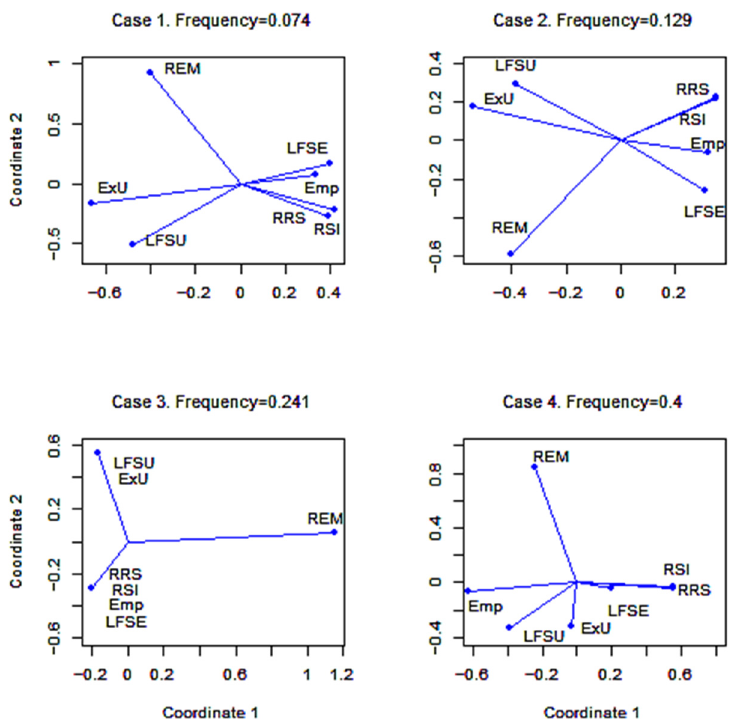
Figure 7. Projections of time series to two-dimensional space for frequencies given in Table